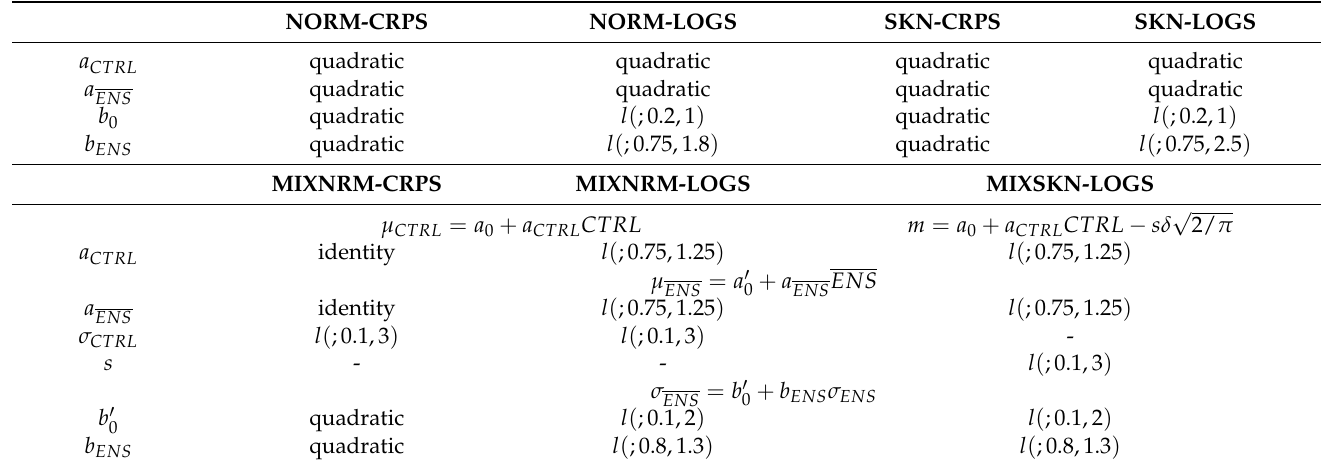
Table 1. Summary of the link functions used for parameter